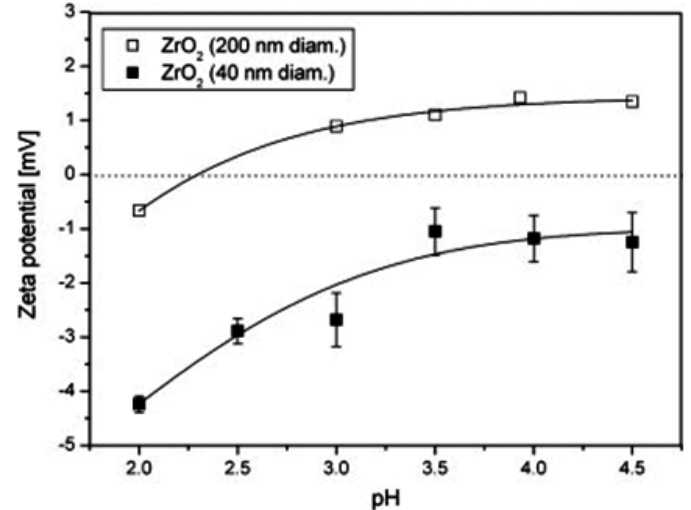
Figure 10. Zeta potential as a function of bath pH, for ZrO average diameters dispersed in the Watts bath